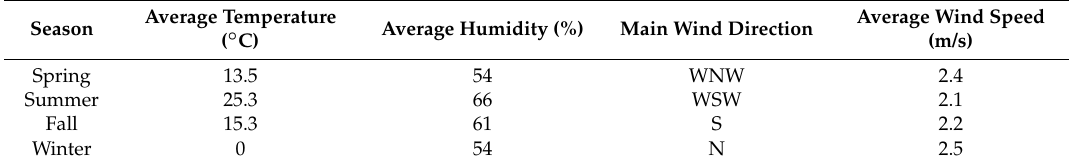
Table 5. Operating meteorological conditions for season (Ulsan industrial